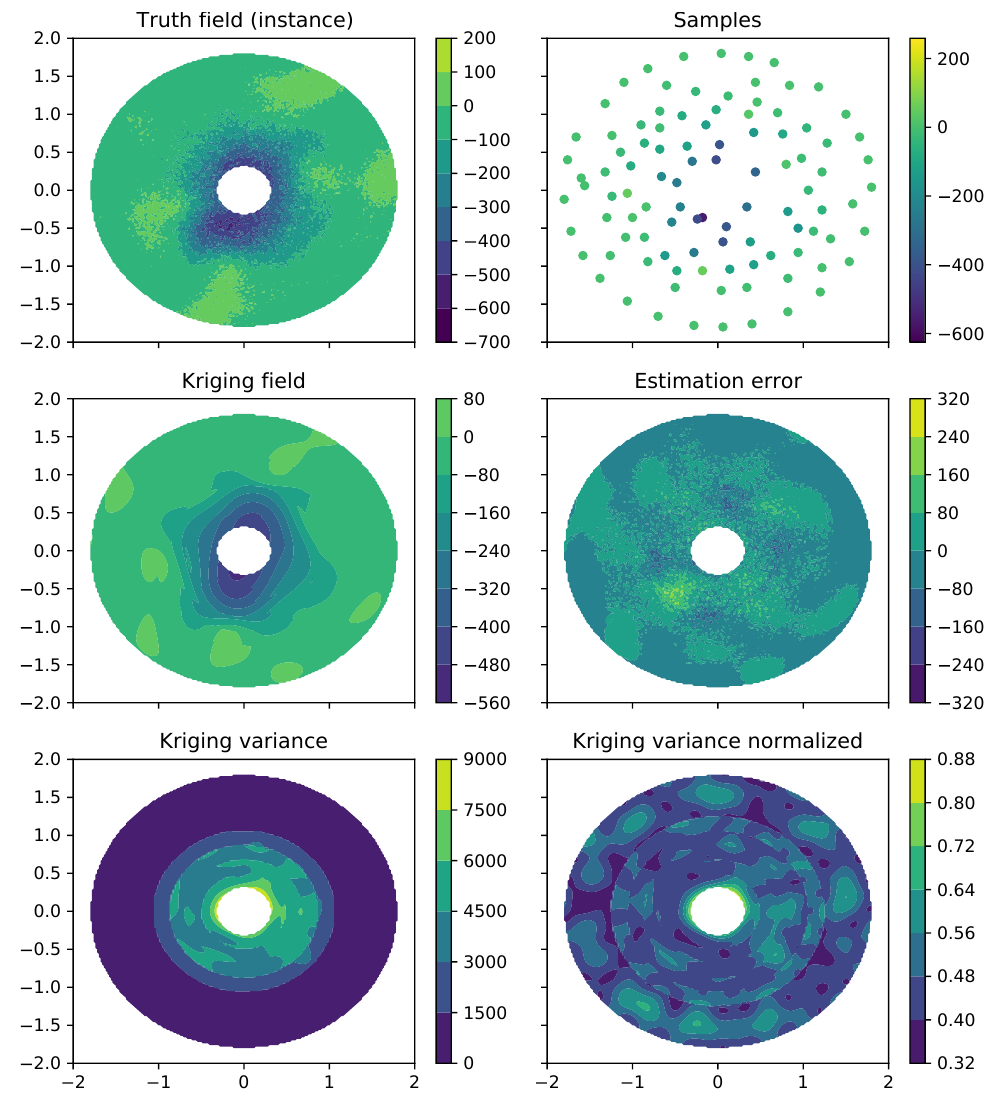
Figure 4. 2D Universal Kriging example after 8 iterations with 10 samples per iteration and 20 initial samples (100 samples in total). For variogram determination the entire truth field was provided to ensure sufficient statistics. Test field possesses no